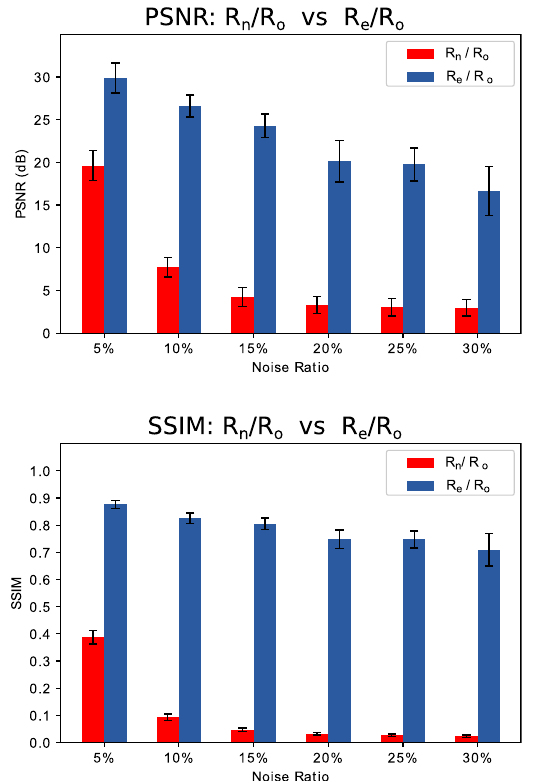
Figure 4. Quantitative comparison between reconstructions ( R n and R e ) obtained from noisy and enhanced projections with the ground truth using Peak signal-to-noise ratio (PSNR) and Structural Similarity Index (SSIM). PSNR and SSIM are computed from the full 3D reconstructed datasets (512 slices). The higher value of PSNR and SSIM means better similarity of the compared images. The maximum value of SSIM is 1.